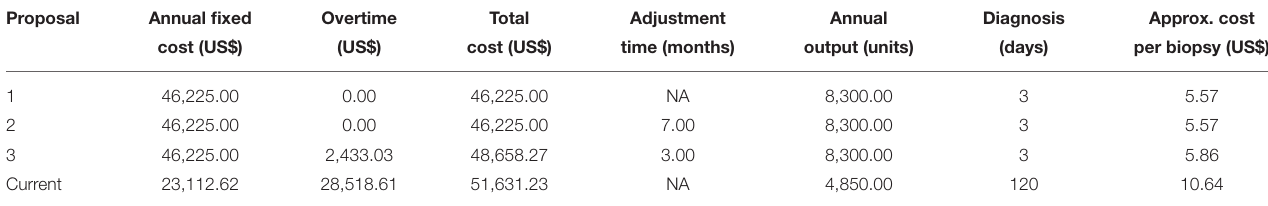
TABLE 8 | Cost benefit analysis for output plan